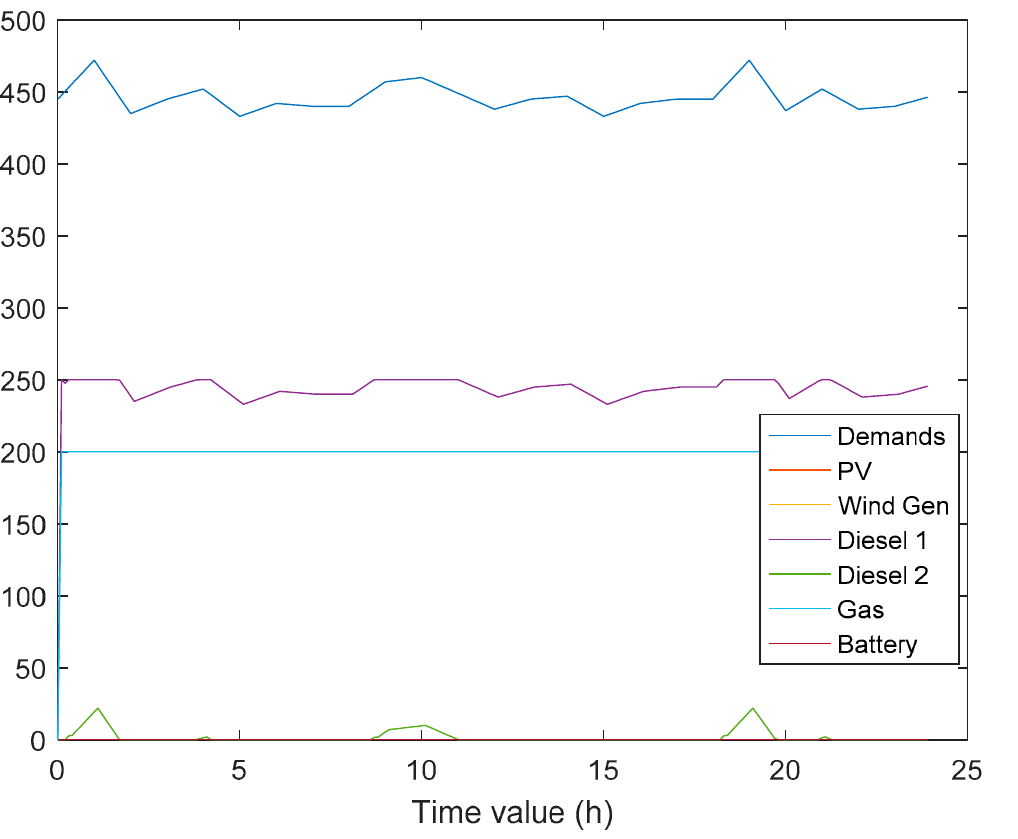
Figure 10. Ship power generation and consumption during Scenario 1. Load demand (blue), DG1 (purple), LNG (light blue), DG2 (light green). PVs (deactivated), WECs (deactivated), Batteries (off). Table 8. Results of Four Scenarios.